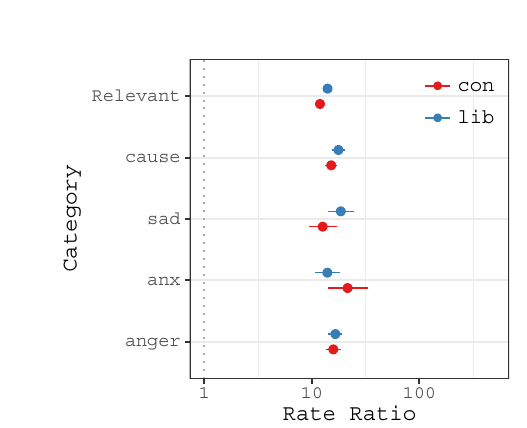
Fig. 1 Overall linguistic shifts in the two groups. Before-after rate ratios ( x -axis) by groups, for the occurrence of the linguistic features ( y -axis). The two groups exhibit a similar change and both have rates signi fi cantly increased from their own base rates (indicated as the vertical line x =